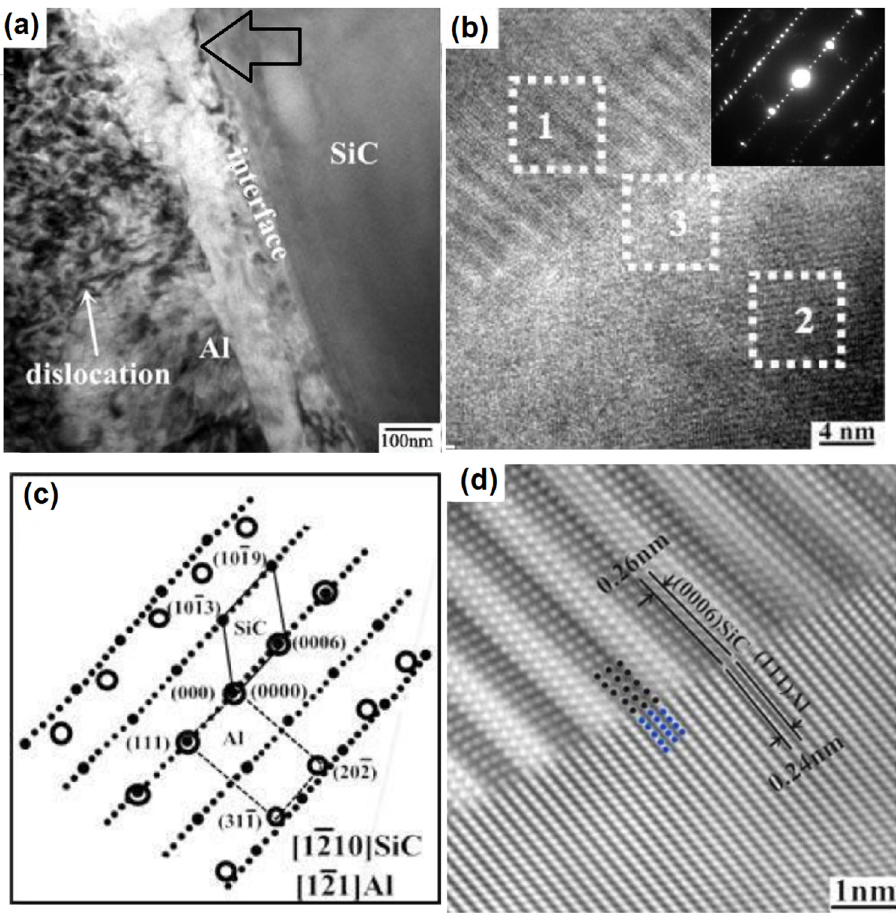
Figure 2: TEM ( a ) and HRTEM ( b ) images of the interface SiC/Al without interfacial products for an SiCp/Al – 1.0Mg – 0.6Si – 0.25Cu composite, ( c ) indexed pattern of the SAED presented in Figure 2b, and ( d ) IFFT of the area 3 in Figure 2b ( Reproduced with permission from [ 84 ] . )